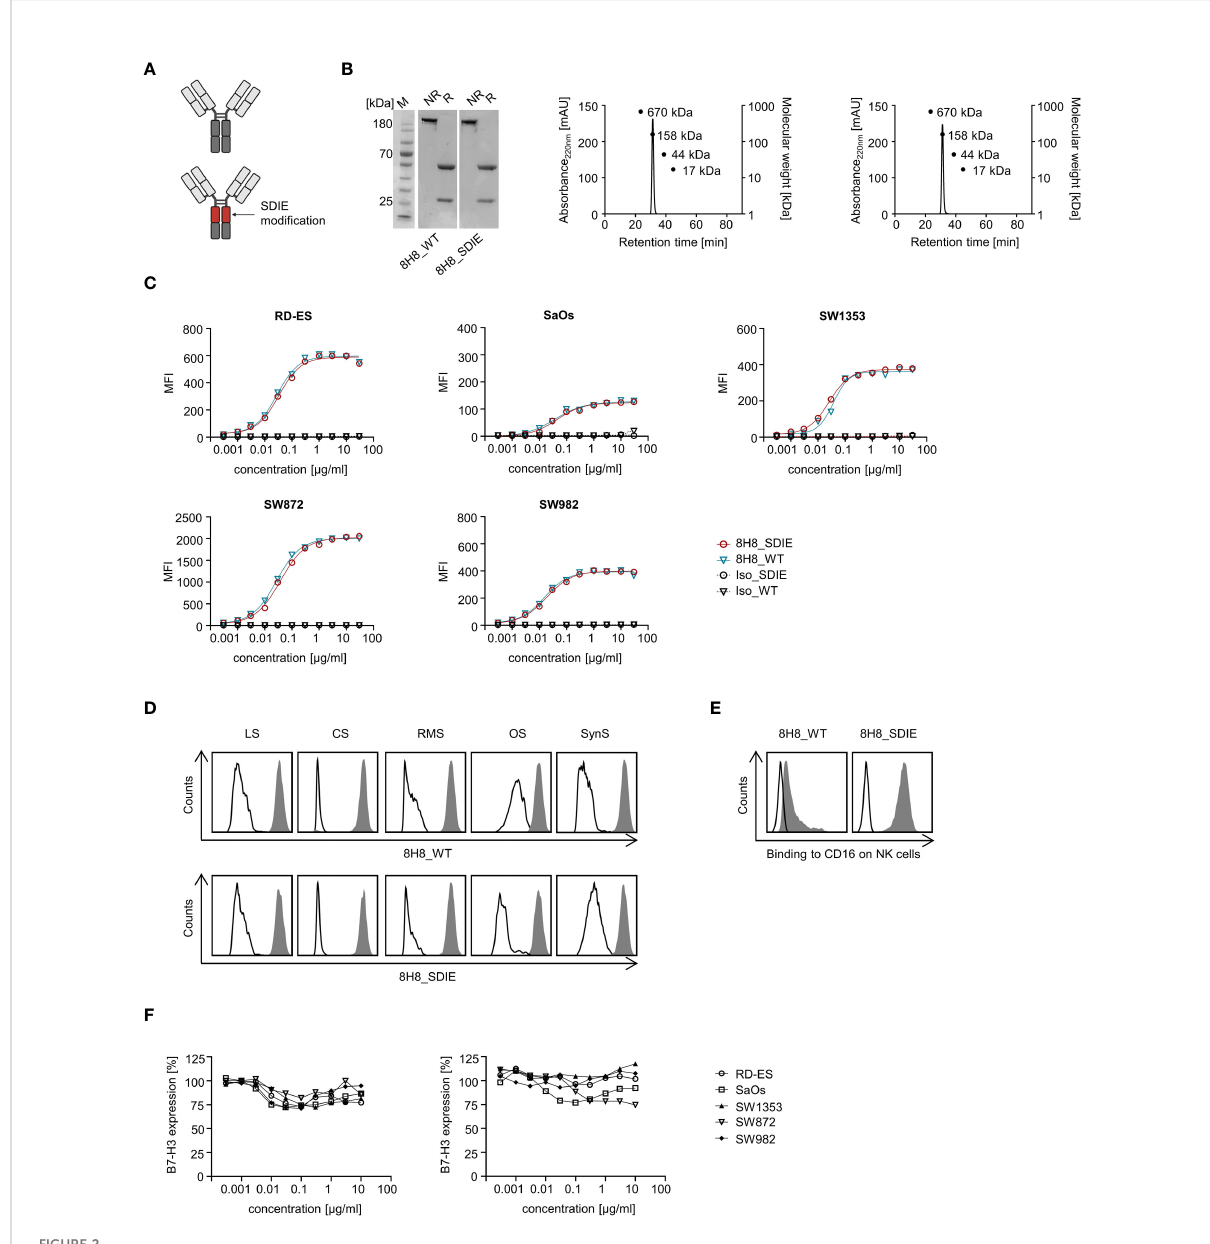
FIGURE 2 Generation and binding characteristics of B7-H3 speci fi c antibodies. (A) Schematic illustration of the generated B7-H3 speci fi c antibodies, either with wildtype Fc part (8H8_WT) (top) or Fc optimized part to enhance af fi nity to CD16 (8H8_SDIE) (bottom). Created with BioRender.com. (B) Exemplary results of an SDS PAGE (left panel) for both B7-H3 antibodies and of size exclusion chromatography for 8H8_WT (middle panel) and 8H8_SDIE (right panel) (C) Sarcoma cell lines were incubated with the indicated concentrations of 8H8_WT, 8H8_SDIE or the corresponding isotype controls followed by an anti-human PE conjugate and analyzed by fl ow cytometry. Exemplary data for mean fl uorescence intensity (MFI) levels from one representative experiment of a total of three with similar results are shown. (D) Binding of 8H8_WT and 8H8_SDIE or the corresponding controls (1 µg/ml) to the surface of patient-derived sarcoma cells was analyzed by fl ow cytometry using the 8H8 antibodies (shaded peaks) and the corresponding isotype controls (open peaks), respectively. (E) Speci fi c binding of 8H8 mAbs to CD16 on NK cells was analyzed by fl ow cytometry using NK cells (CD3 - CD56 + ) within healthy donor PBMC incubated without (open peaks) or with the 8H8 mAbs (shaded peaks) followed by an anti-human PE conjugate. (F) Sarcoma cells RD-ES, SaOs, SW1353, SW872 and SW982 were incubated with indicated concentrations of 8H8_WT, 8H8_SDIE or the corresponding controls for 24 h (left panel) or 72 h (right panel), respectively. Then, cells were washed and reincubated with 1 m g/ml of 8H8_SDIE, followed by an anti-human PE conjugate (1:100) and then analyzed by fl ow cytometry. Relative surface expression of B7-H3 was calculated by de fi ning the mean fl uorescence intensity of cells preincubated without antibody as 100%. Exemplary data from one representative experiment of a total of three are